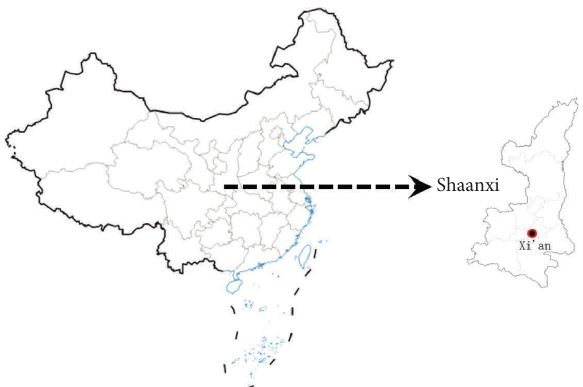
Figure 1: Test site.